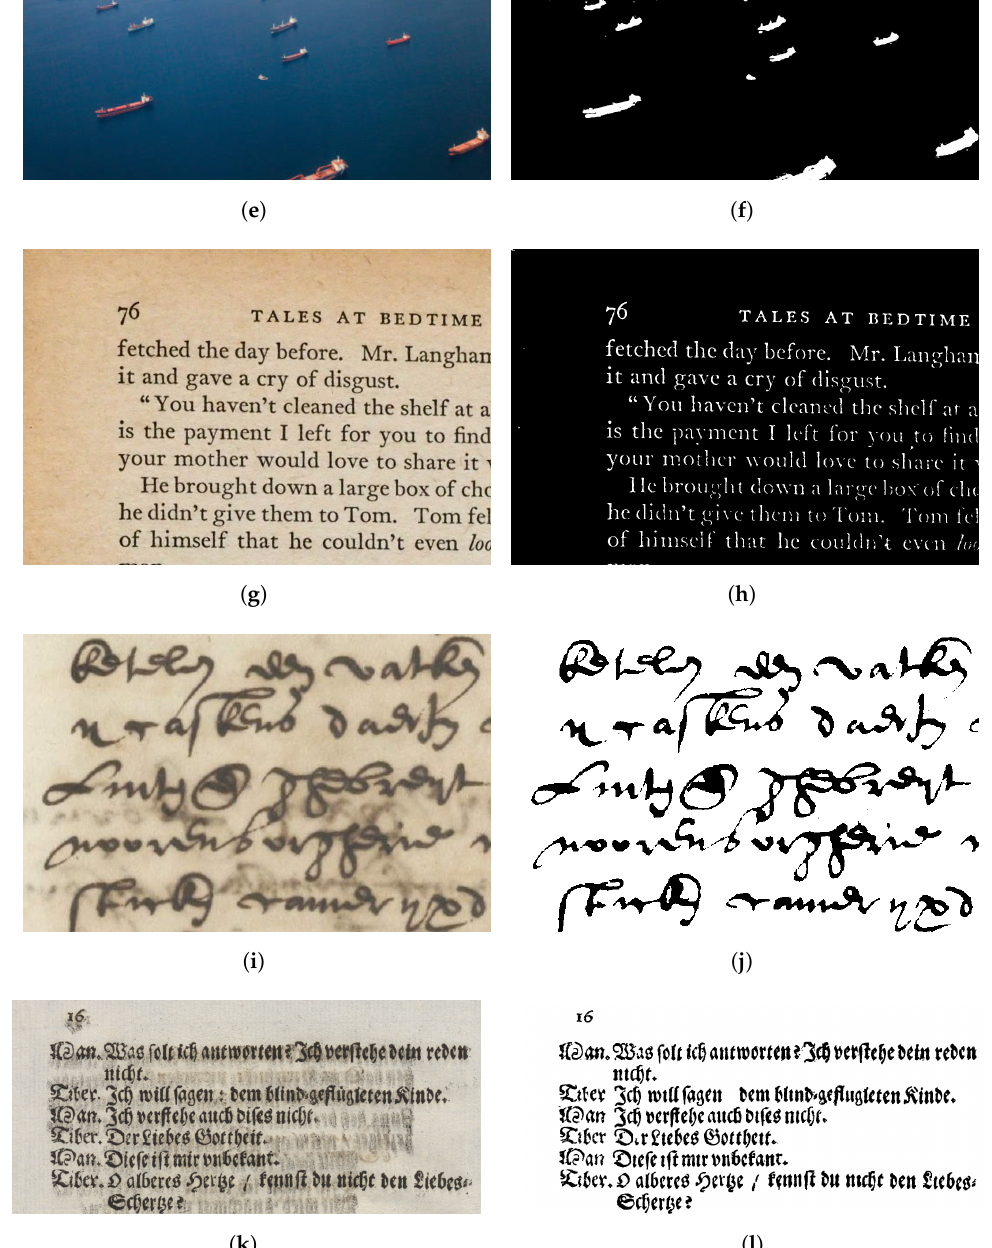
Figure 10. Different sample images and the corresponding globally and locally thresholded outputs: ( a , b ) screws on a wooden table; ( c , d ) needles on a red background; ( e , f ) a drone image of container ships; ( g , h ) a photo of an old text document; ( i – l ) text with noise in the background from the DIBCO dataset